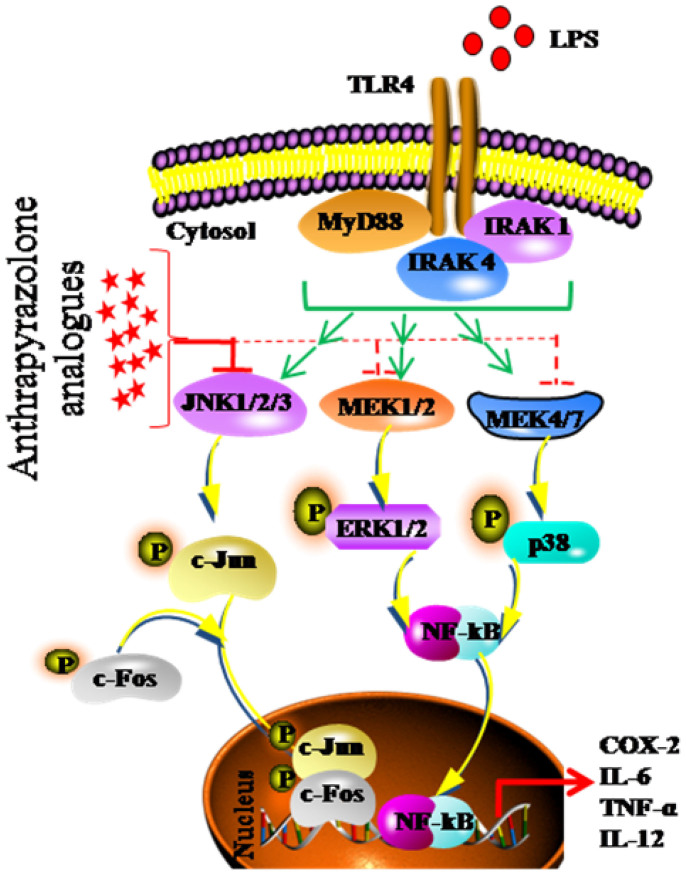
Endotoxin (LPS) mediated activation of JNK through Toll Like Receptor 4 (TLR4).Analogues of SP600125 or anthrapyrazolone inhibit JNK activity.